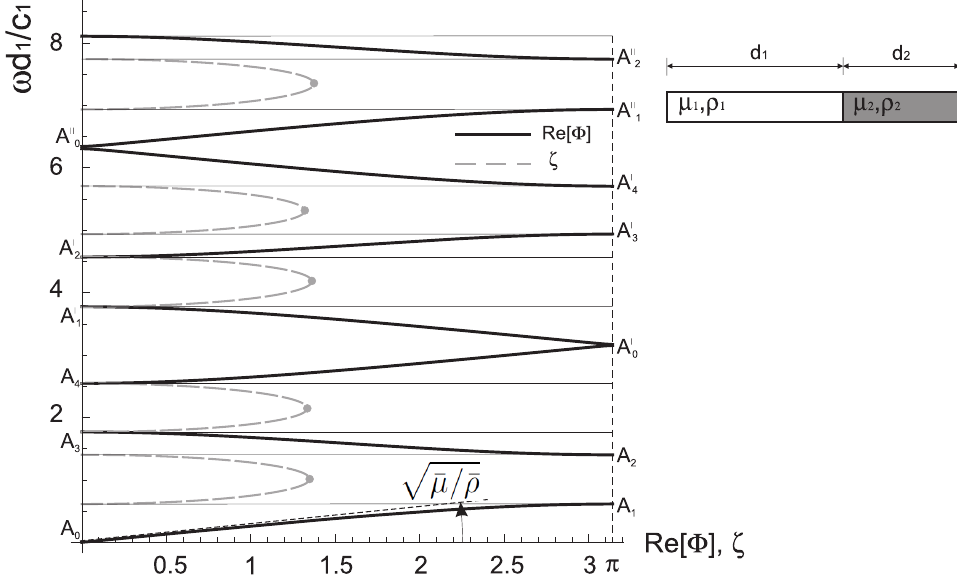
Figure 3. Continuous laminate. Dispersion diagram and decay exponent ζ for a two-layer continuous system. The Bloch parameter Re [ φ ] (continuous black lines) and the decay exponent ζ (dashed grey lines) are given as a function of the angular frequency ω . The material and geometric parameters are: shear moduli, µ 1 = 33 × 10 3 MPa, µ 2 = 201 × 10 3 MPa; mass densities ρ 1 = 2300 kg/m 3 , ρ 2 = 7800 kg/m 3 ; phase lengths d 1 = 0.27 m, d 2 = 0.73